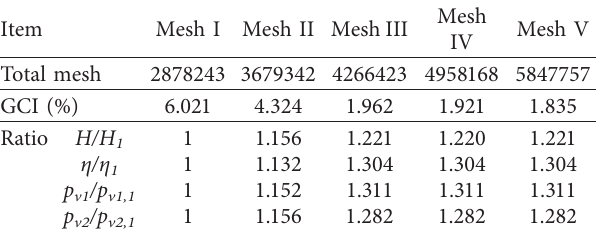
Figure 3: Arrangement of monitor points. Table 2: Grid cells of the selected mesh.